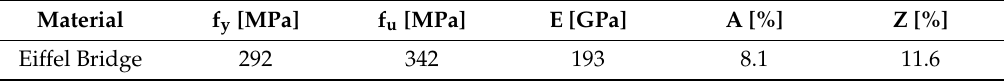
Figure 3. The microstructure of Eiffel puddle iron (etched 5%HNO 3 , light microscopy). ( a ) Enlarged ferrite grains with non-metallic inclusion chains. (A) Noticeable different grain size with the brittle phase precipitations inside ferrite grains (B); ( b ) magnified ferrite grain structure containing large non-metallic inclusions (A). Table 3. Static tensile test results (according to the Portuguese NP10002-1 Standard).